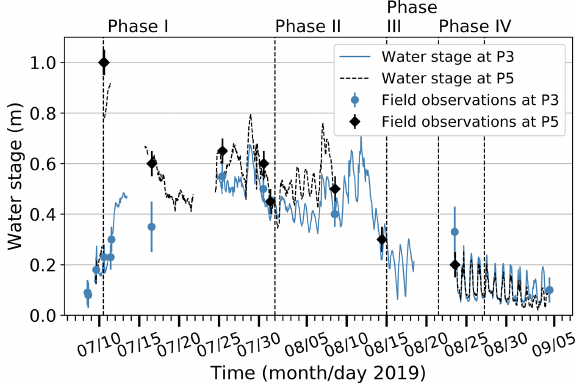
Figure 5. Hourly time series of the water stage at P5 (dashed black line) and P3 (blue line) from continuous pressure measurements. Direct observations (and associated standard errors) from field visits are marked by black diamonds and blue dots for P5 and P3, respec- tively. Part of the discrepancies between direct field observations and the continuous water stage from pressure sensors can be ex- plained by the probing not always being made at the exact location of the